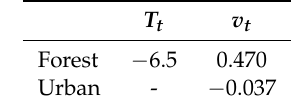
Table 5. Thresholds ( T t and v t ) for the forest and urban